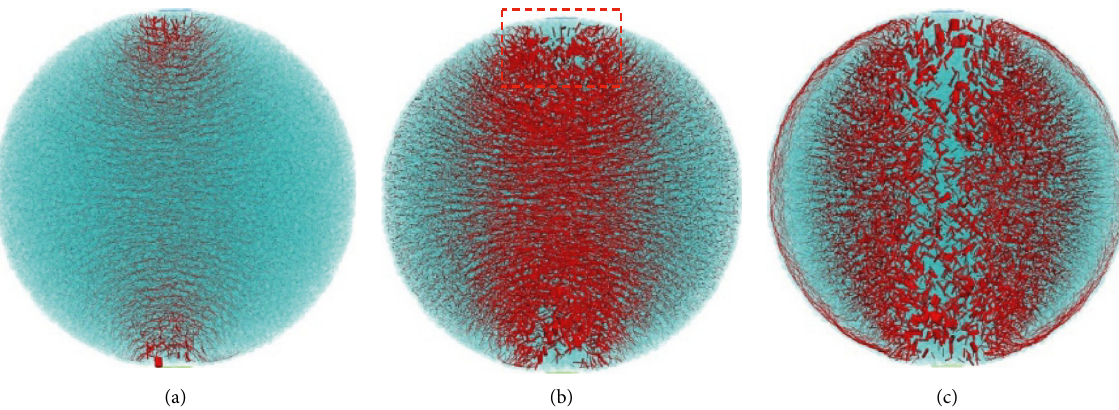
Figure 12: Distribution diagram of the tension chain: (a) 0.662kN, (b) 4.089kN, and (c) breaking moment.